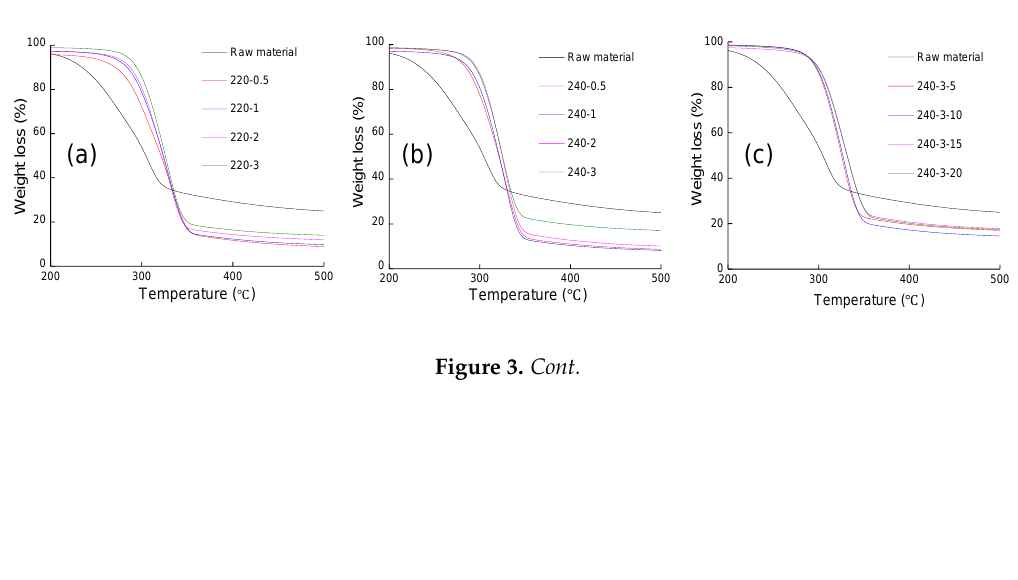
Figure 3. TG (thermogravimetry) ( a – c ) and DTG (differential TG) ( d – f ) profiles of raw material and glycerol pretreated corncobs. 3.5. Levoglucosan Production from Glycerol Pretreated Corncobs Cellulose pyrolysis involves primary and secondary reactions. The initial breakage of glucosidic bonds and the formation of active cellulose occur in the primary reaction. In the secondary reaction, the active cellulose is further degraded to levoglucosan by dehydration of side functional groups [25]. The further decomposition of levoglucosan results in the formation of furfural, 5-HMF, hydroxyacetone, hydroxyacetaldehyde and some C 1 -C 2 molecules. The yields of the main products from un-treated and glycerol pretreated corncobs’ fast pyrolysis are presented in Table 6. Compared with raw material, the glycerol pretreated samples yielded more 5-HMF and simultaneously less acetic acid and furfural. Without the pretreatment step, the un-treated corncobs released only 2.2% levoglucosan during the fast pyrolysis. Levoglucosan yields from glycerol pretreated corncobs were obviously higher than that of un-treated material. Glycerol pretreatment improved the downstream levoglucosan yield in fast pyrolysis. The further increase in pretreatment temperature and residence time had a positive influence on levoglucosan formation. The maximum levoglucosan yield (35.8%) was achieved from the 240-3 sample, which was obviously higher than that from the un-treated sample. Table 6. Yields of main compounds from un-treated and glycerol pretreated corncobs in fast pyrolysis. 5-HMF: 5-hydroxymethylfurfural. Samples